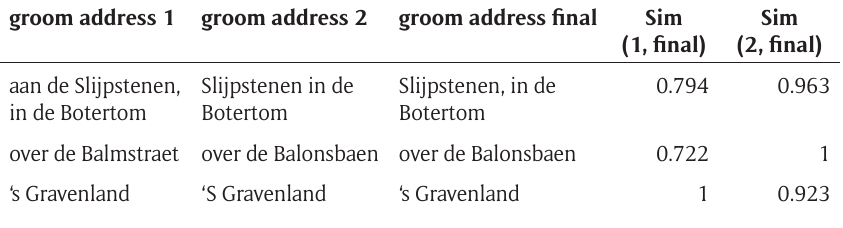
Table 4: Example records for the measurement of transcriptions’